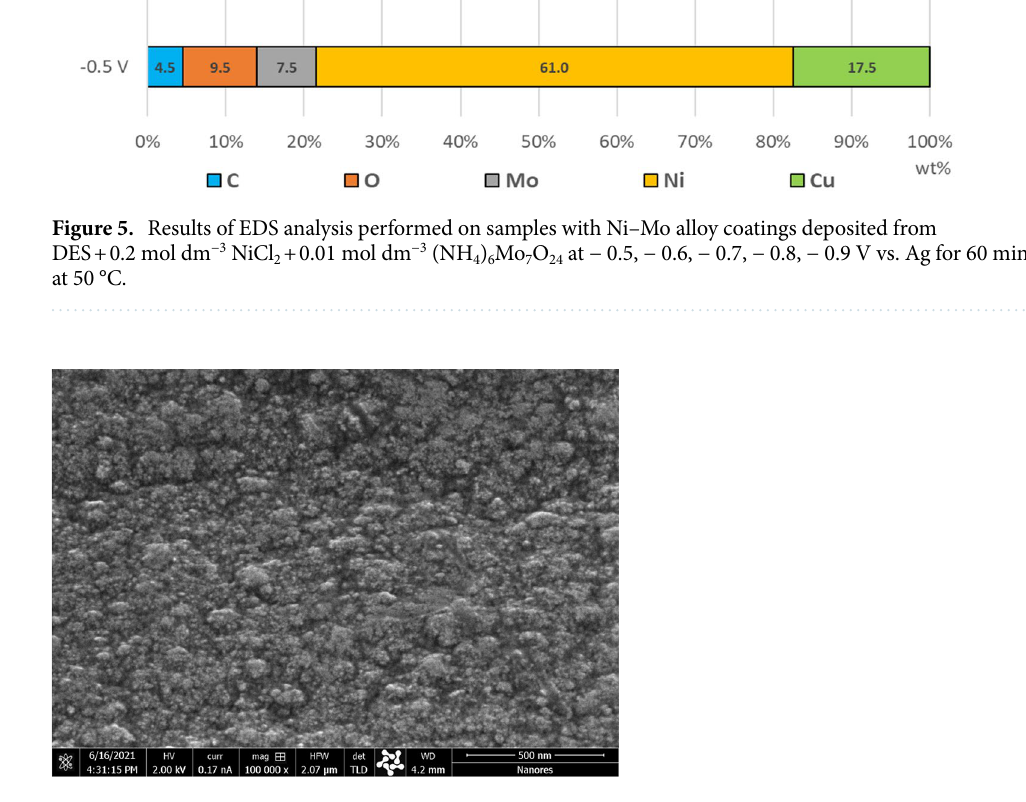
Figure 6. HR-SEM micrograph of the surface of Ni–Mo alloy coating deposited from DES + 0.2 mol dm −3 NiCl 2 + 0.01 mol dm −3 (NH 4 ) 6 Mo 7 O 24 at − 0.6 V vs. Ag for 60 min at 50